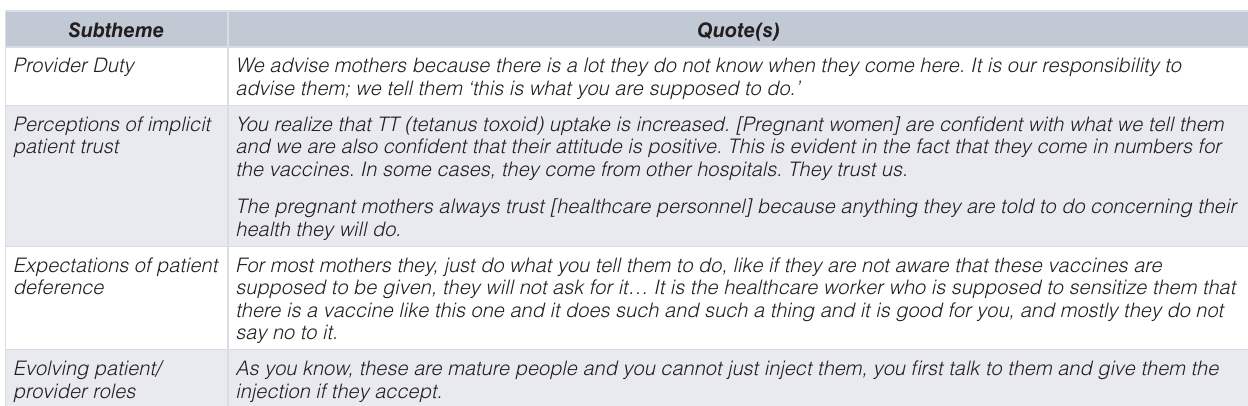
Table 1. Centrality of patient-provider relationship in vaccine